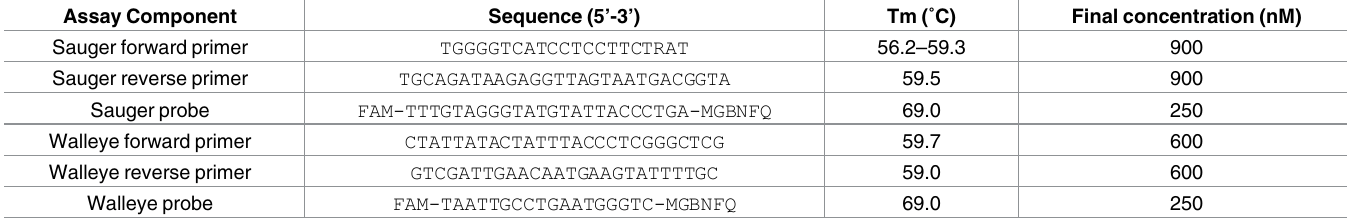
Table 2. Primers and probes to detect sauger and walleye using